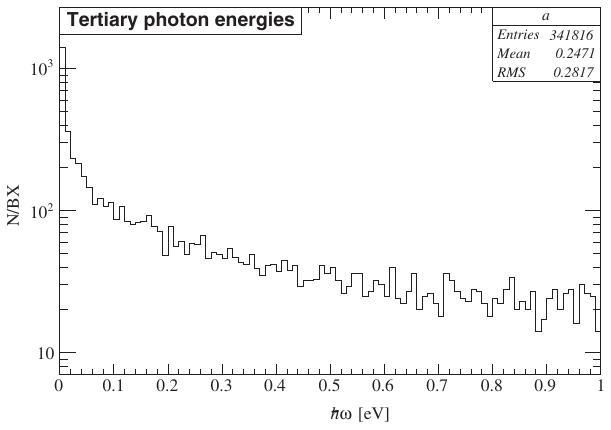
FIG. 21. Low-energy part of the tertiary photon spectrum.